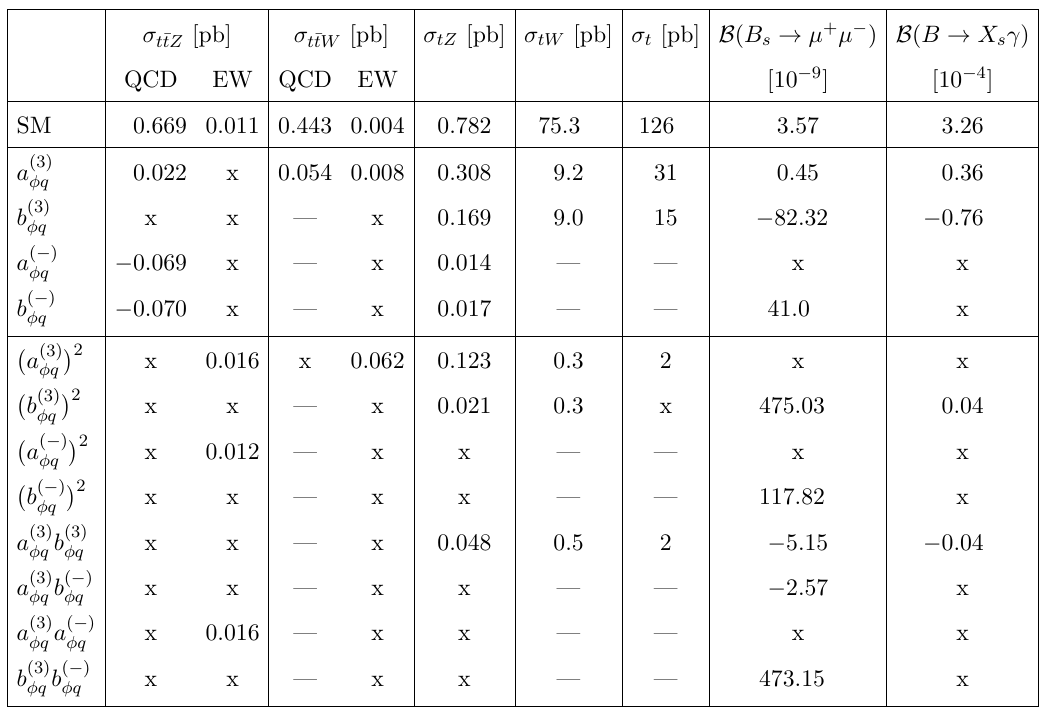
, σ , σ and t -channel single top tZ t ¯ tZ t ¯ tW are given at NLO QCD. The tW